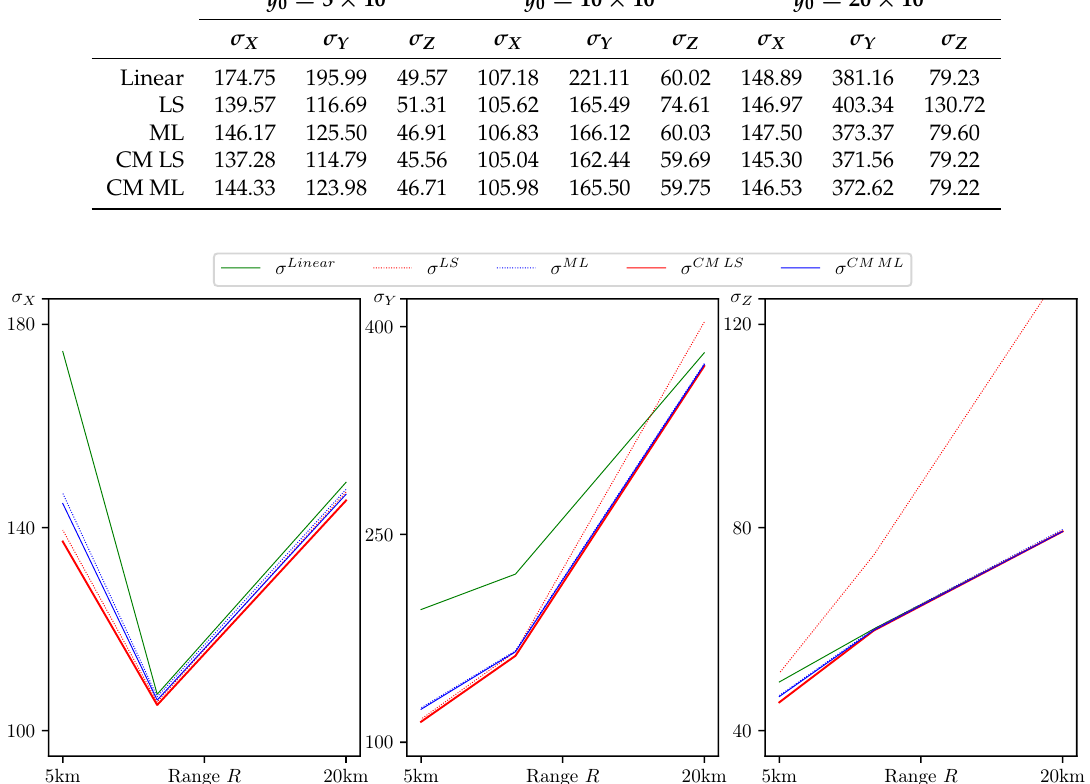
Figure 3. Coordinate-wise std of estimation error σ E for E ∈ { Linear , LS , ML , CMLS , CMML }